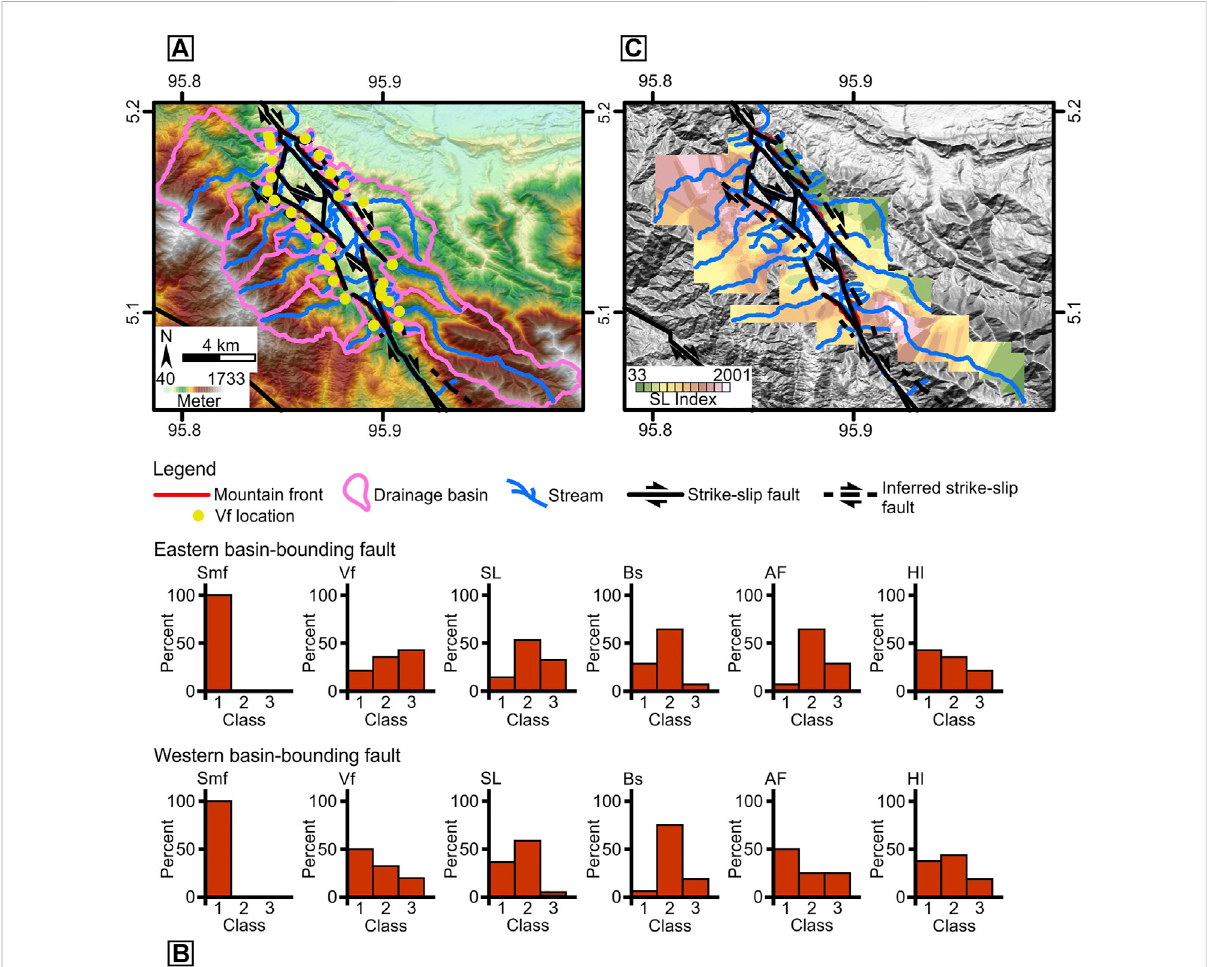
FIGURE 7 The Alue Calong Basin: (A) the mountain fronts, faults, and drainage basins, (B) classi fi cation of geomorphic indices, and (C) stream length- gradient